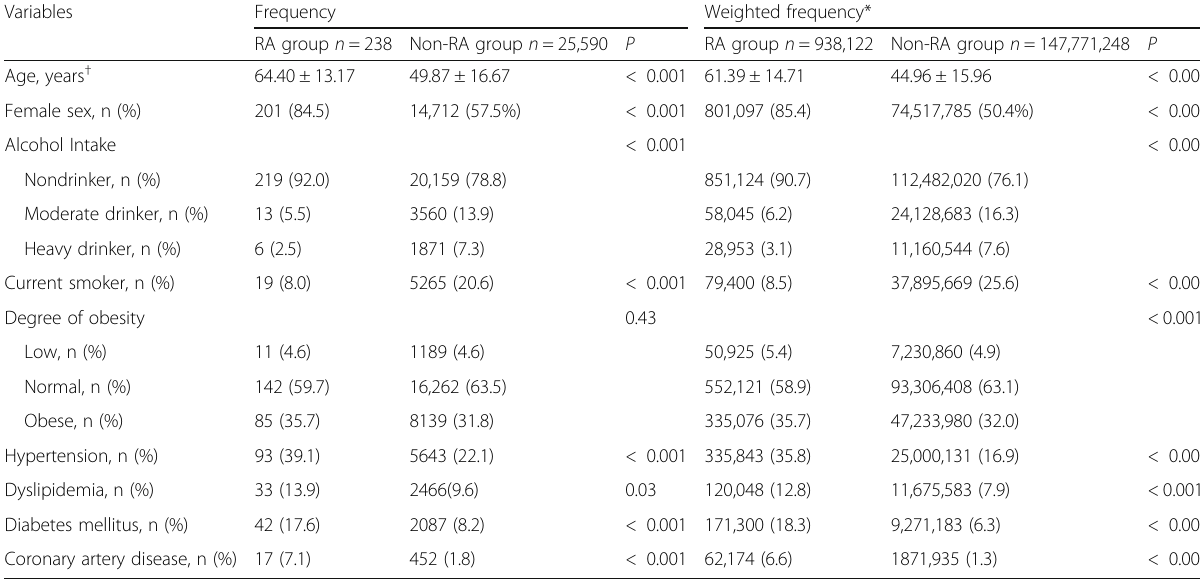
Table 1 Baseline characteristics of the study participants Variables